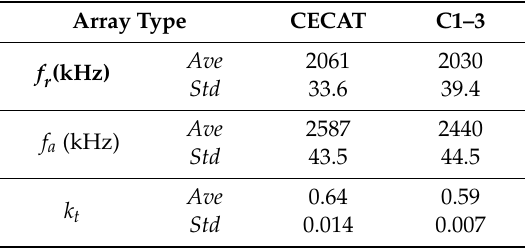
Table 3. Analysed parameters for both active layers.